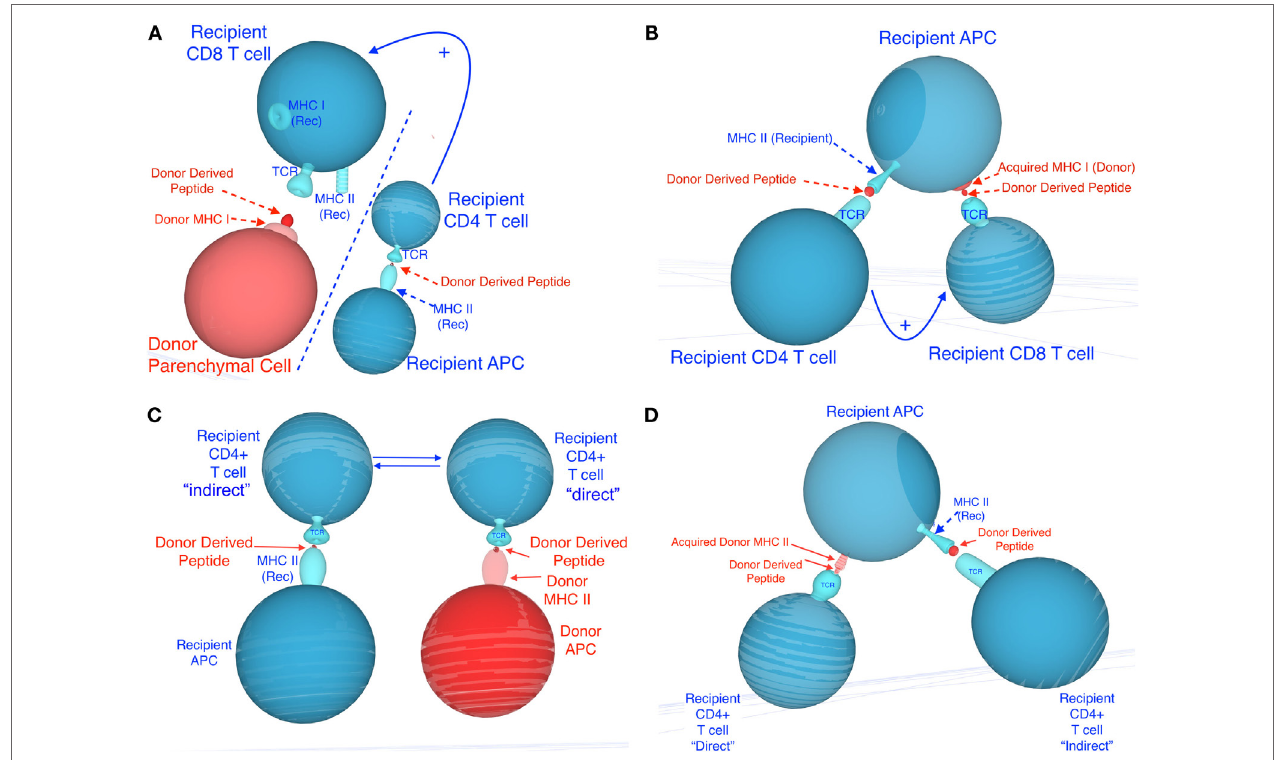
FiGURe 1 | Potential mechanisms involved in semi-direct allorecognition by recipient CD4 + and CD8 + T cells . Recipient cells are shown in blue and donor cells and peptides are shown in red. (A) depicts the classical four-cell cluster model in which CD4 + T cells activated indirectly [ via recognition of recipient major histocompatibility complex (MHC) class II + donor peptide, displayed on recipient antigen-presenting cells (APCs)] may provide help for CD8 + T cells activated directly ( via recognition of donor MHC class I on donor APCs). (C) depicts the traditional four-cell cluster model in which CD4 + T cells activated indirectly ( via recognition of recipient MHC class II + donor peptide, displayed on recipient APCs) and CD4 + T cells activated directly ( via recognition of donor MHC class II on donor APCs). (B,D) describe different mechanisms by which semi-direct allorecognition could allow for a three-cell cluster model in which different T cells recognize different antigens on the same recipient APCs. This process would optimize T cell help by CD4 + T cells activated indirectly for CD8 + T cell activated directly (recognition of acquired MHC class I) (B) and enhance cooperation between CD4 + T cells activated directly ( via recognition of acquired donor MHC class II) and indirectly (recipient MHC class II + donor peptide) (D)